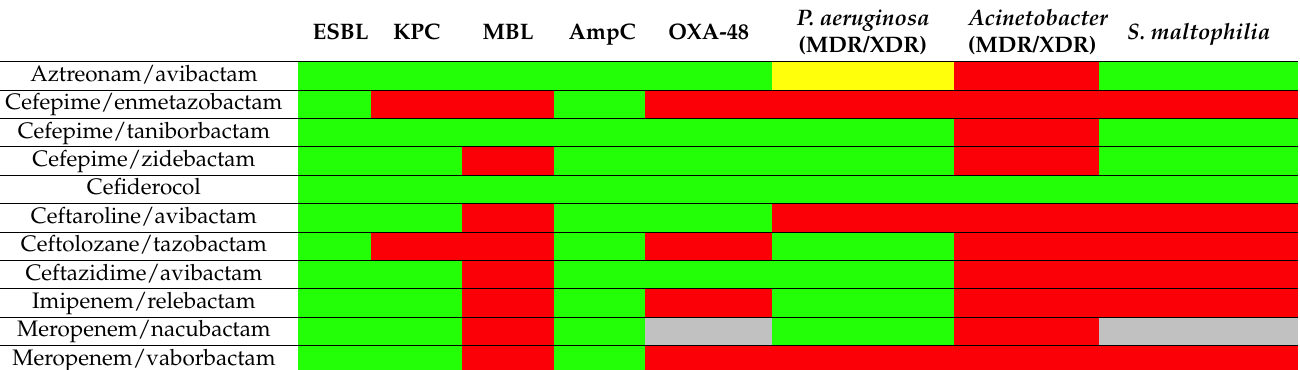
Table 1. Microbiological